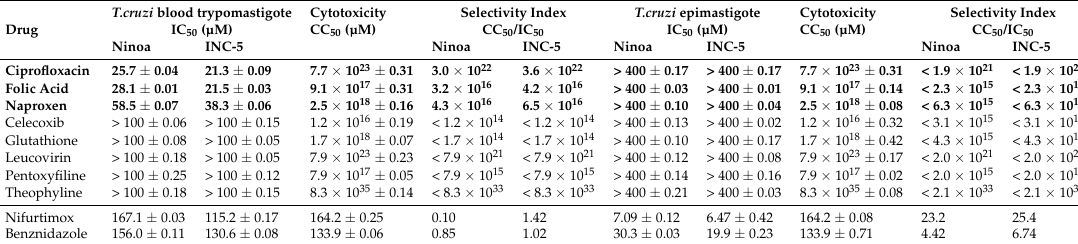
Table 3. Inhibition of proliferation of Ninoa and INC-5 strains of T. cruzi , cytotoxicity and selectivity index of tested FDA-approved drugs compared to the known treatments with nifurtimox and benznidazole (positive